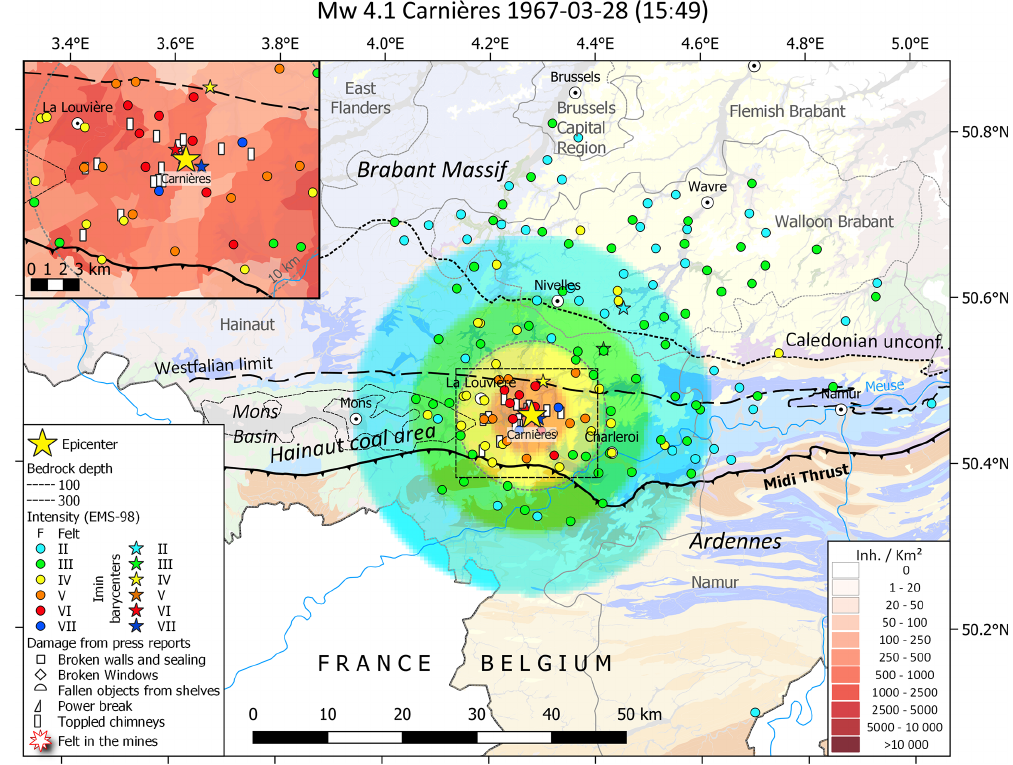
Figure 3. Intensity information of Hainaut events is represented in macroseismic maps such as for the 1967 M w = 4 . 1 ( M L = 4 . 5) Carnières earthquake (no. 21 in Table 1). The inset shows localities where specific damage was reported in press reports. Note the asymmetric macro- seismic field: this event was felt more northwards within the borders of the Brabant Massif than southwards in the Ardenne, which results in a northwards shift of the lower I min intensity (IV, III and II) barycentres. In the background, the Hainaut intensity attenuation model developed in this study (see Sect. 4.2) is applied to the parameters of this event. Note that this attenuation model only can be applied within the coal area (between the Midi Thrust and Westphalian limit). Modelled I max = VI, but locally intensity of VII was observed. See the Atlas in the Supplement for other events. Geology in the background based upon http://www.onegeology.org/. Reproduced with the permission of © OneGeology. All rights reserved. Times in all figures are given in